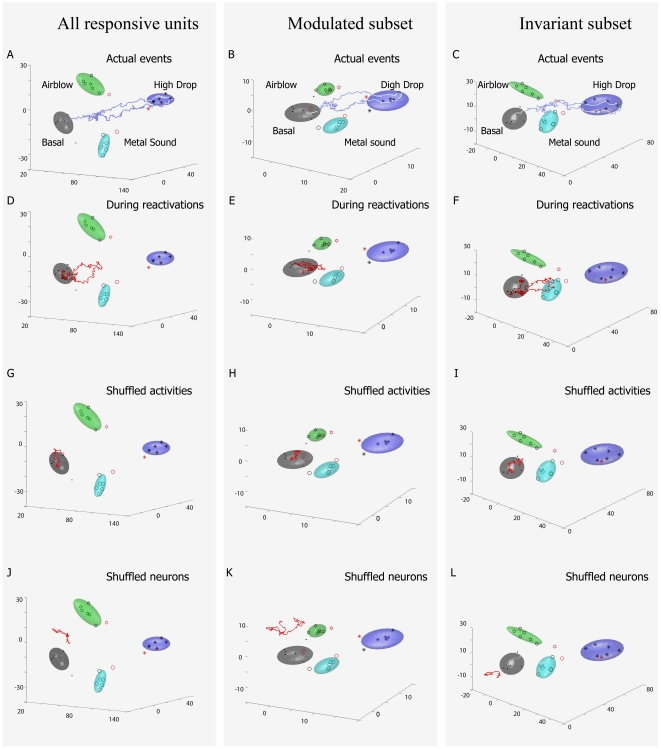
Shuffling techniques illustrate the specificity of the encoding
patterns during learning and reactivations.We shuffled the spike responses of the top 50 invariant units during a
drop reactivation using a time window of 2 seconds before and after the
occurrence of the putative reactivation (by placing the spikes in 50 ms
time bins and performing random permutation of the whole sequence). As a
result, the projected trajectories are now located mainly inside the
rest clusters (6G, H and I, are listed). The prior to shuffling was
presented in panel A-F for comparison.